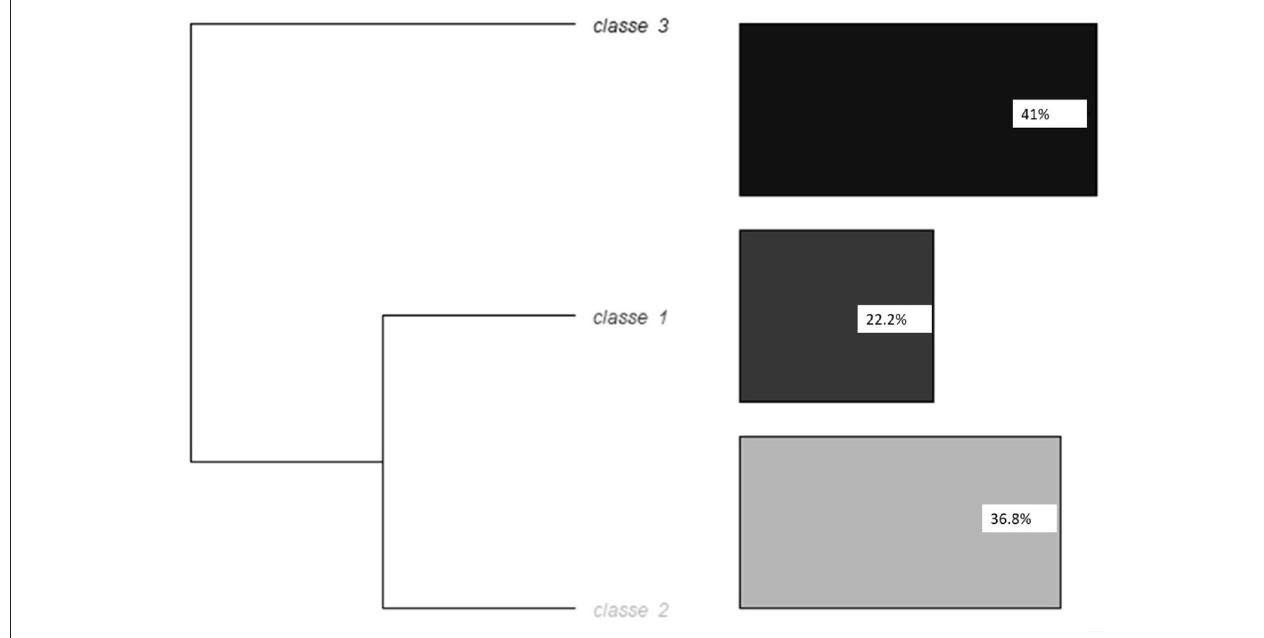
FIGURE 2 | Dendrogram of the hierarchical descendant analysis method